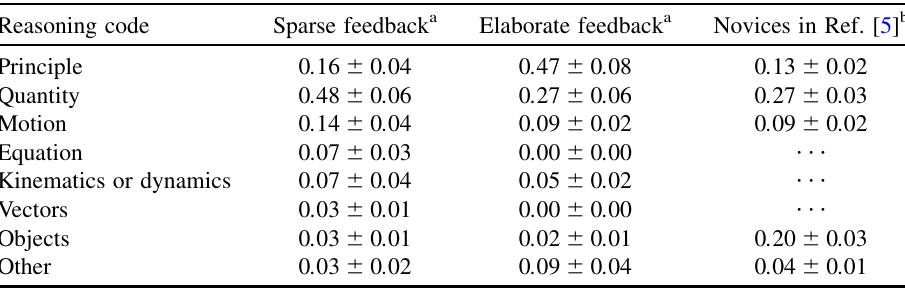
TABLE II. Proportion of typed reasoning statements assigned each code for each condition, plus or minus the standard error of the proportion. Participants in the elaborate feedback condition cited principles to a greater extent whereas the sparse feedback condition relied on quantities for their reasoning